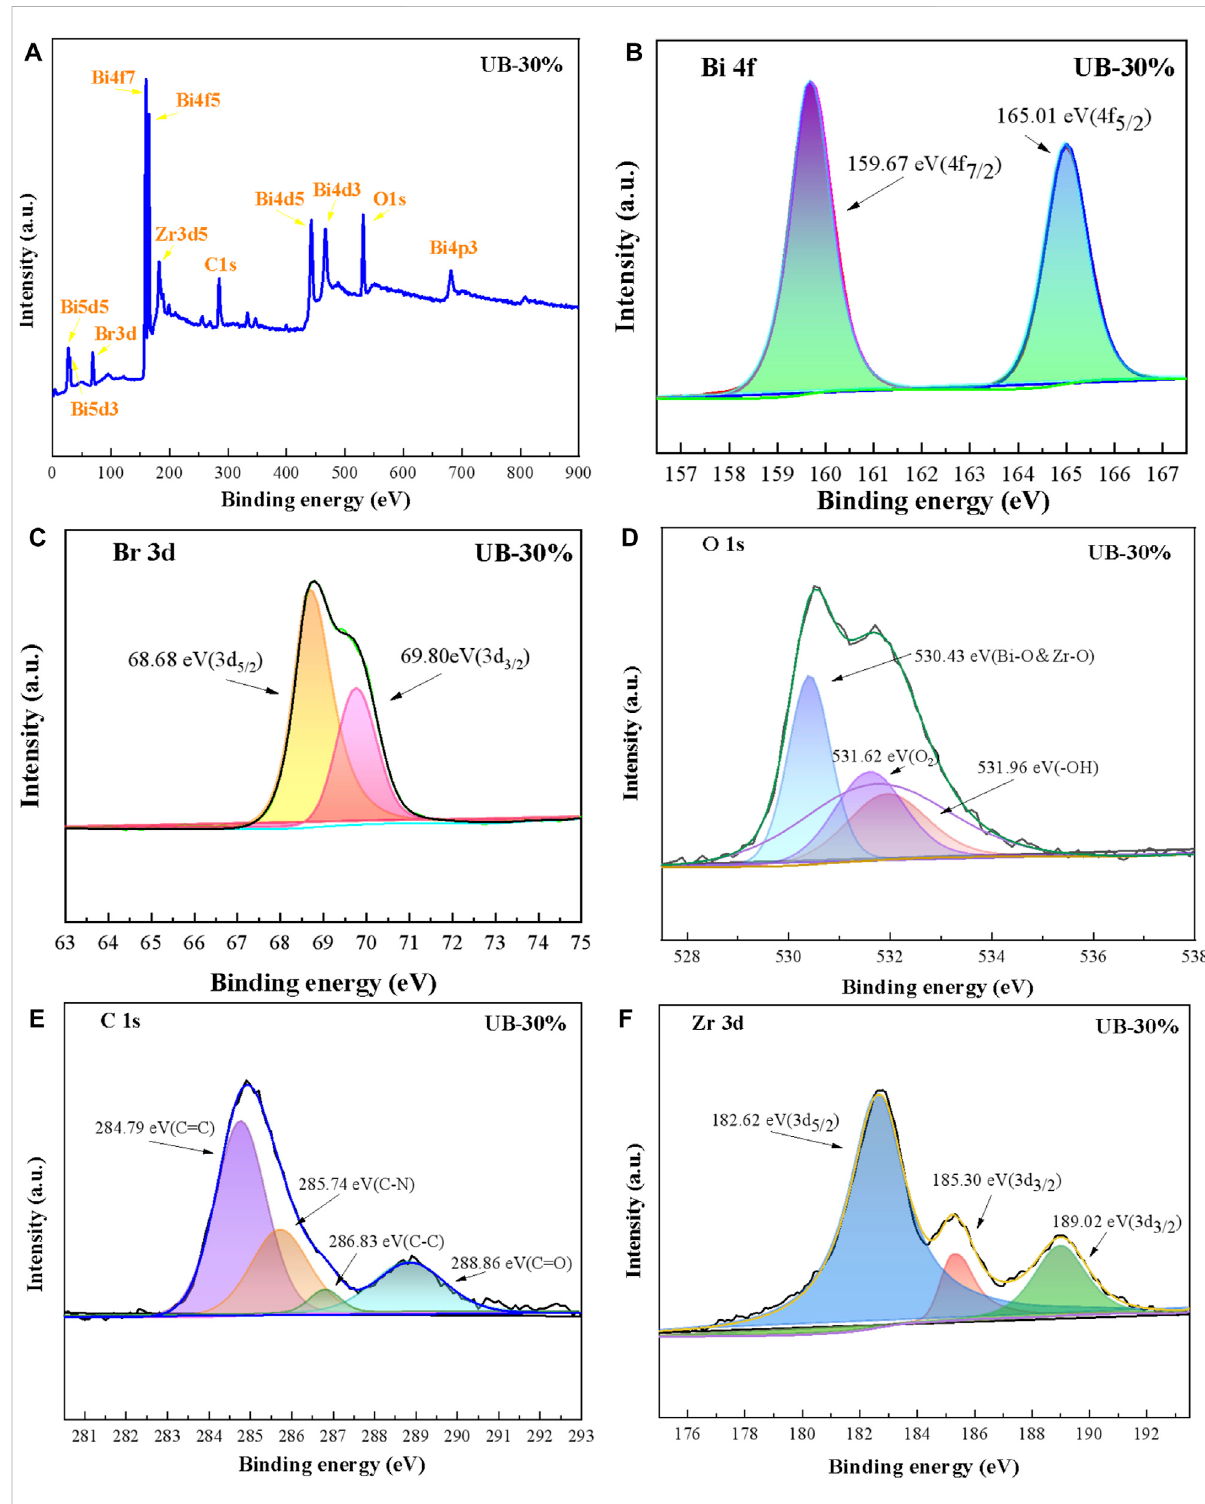
FIGURE 4 XPS spectra of UB-30% (A) the full spectrum of UB-30%; the spectra of UB-30%: (B) Bi 4f; (C) Br 3d; (D) O1s; (E) C1s; (F) Zr